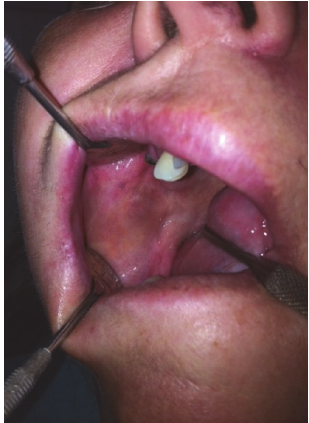
Figure 5: Third following visit: hemangioma disappeared without